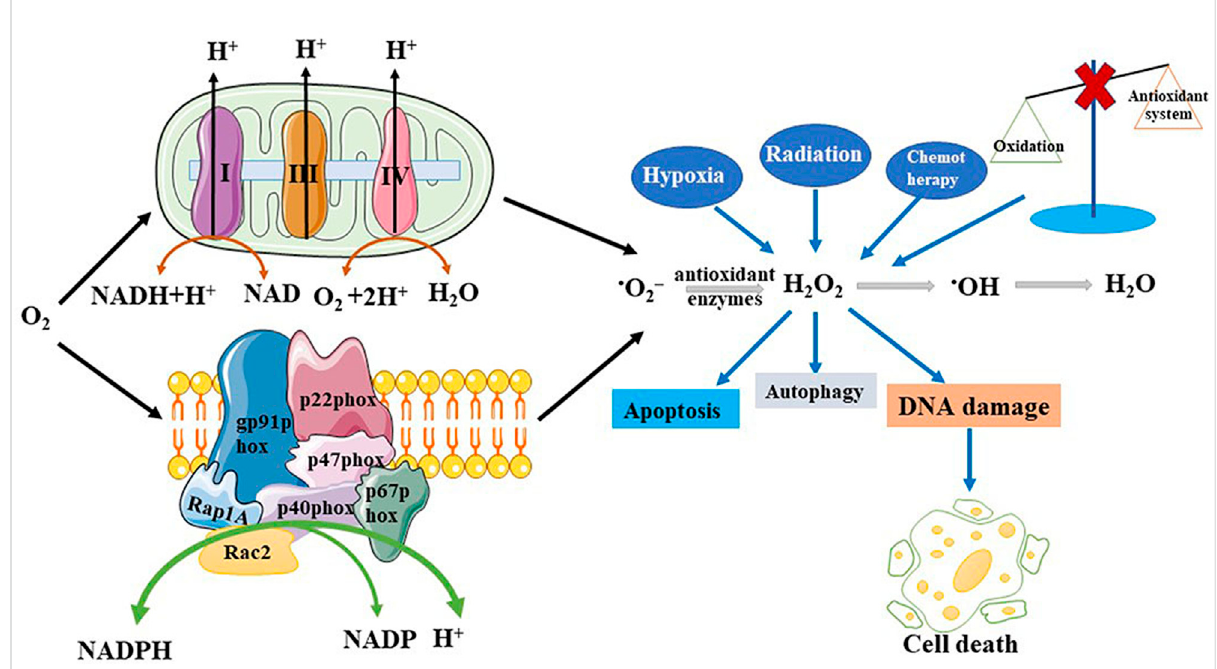
FIGURE 1 Production and regulation of reactive oxygen species (ROS). ROS can be generated both by the endogenous and exogenous pathways. Endogenous pathway includes the mitochondrial respiratory chain and NADPH oxidase. Exogenous pathway includes hypoxia, chemotherapy, and radiation, among others. When oxidation is imbalanced with antioxidant systems will overproduce ROS. And these pathways lead to disease production, promote DNA damage, increase cell autophagy and